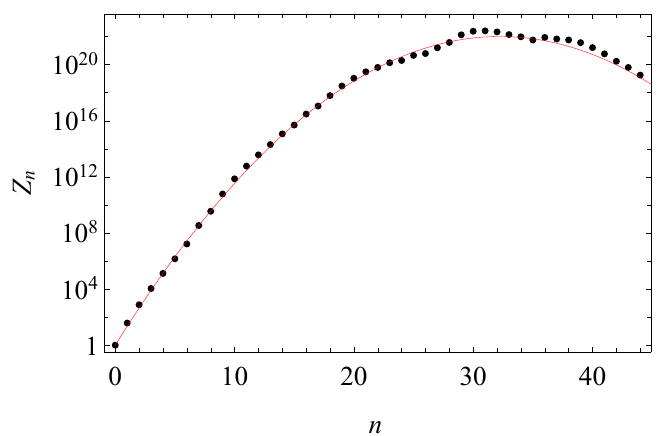
Figure 2. Elliptic genera of the self-dual strings in (2,0) A 1 SCFT computed up to n = 45 charges. The chemical potentials are (cid:15) 1 = 0 . 433 , (cid:15) 2 = − 0 . 354 , β = π , and m = πi . Red line is the Gaussian approximation given by Z n = exp asymptotic form in the Cardy limit well approximates the elliptic